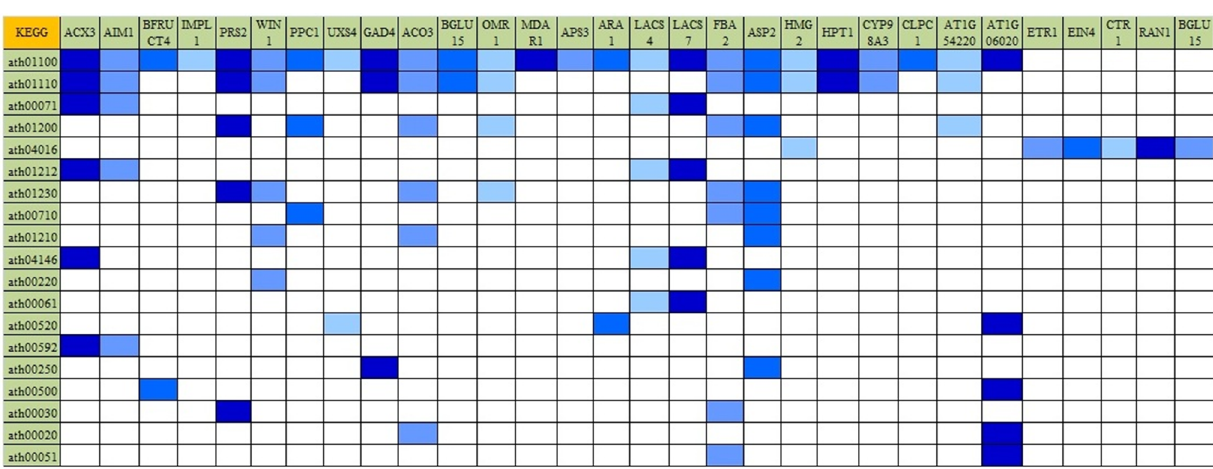
Figure 18. Kyoto Encyclopaedia of Genes and Genomes (KEGG) classification of top differentially expressed (down-regulated) genes. The genes were enlisted at the top and the colour pattern (blue shades) indicates the involvement of a particular gene in a particular KEGG